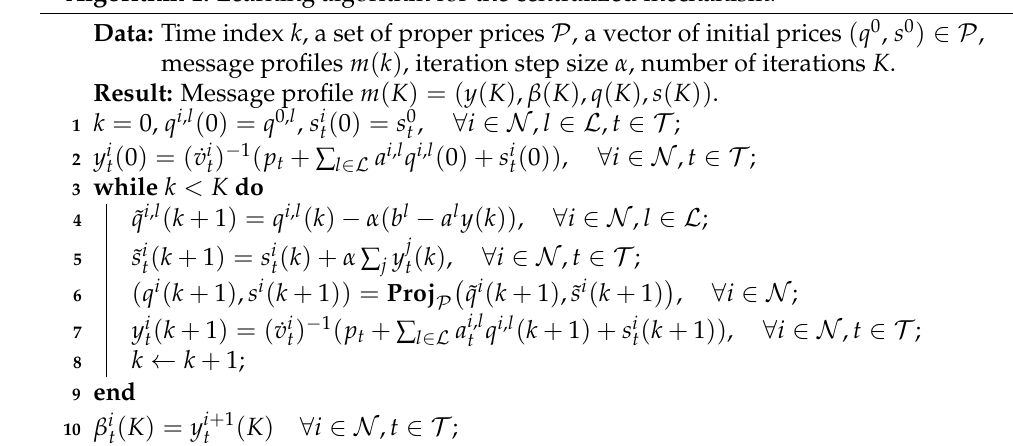
Algorithm 1: Learning algorithm for the centralized